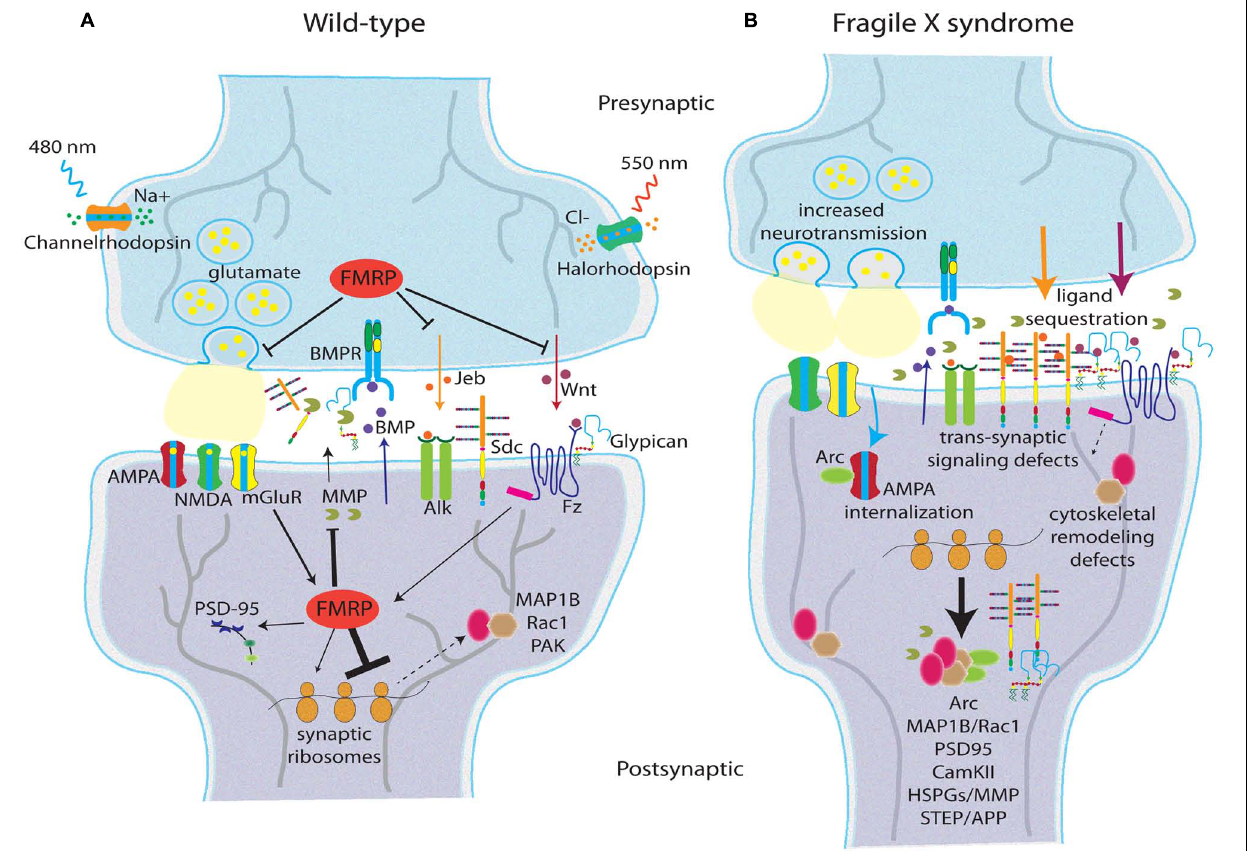
FIGURE 2 | Synaptic changes in the Fragile X syndrome disease state. Schematic depictions of glutamatergic synapses in wild type (A) and FXS (B) conditions showing molecular changes in the response to activity. Data reflect human FXS patient studies, as well as mouse and Drosophila FXS animal models. (A) In wild-type, FMRP regulates glutamate release and anterograde trans -synaptic signaling (e.g., Jeb and Wnt), but does not demonstrably affect retrograde signaling (e.g., BMP; Friedman etal., 2013). FMRP acts as a translational repressor limiting synthesis of cytoskeletal regulators (e.g., MAP1B, Rac1, PAK; Zhang etal., 2001; Bongmba etal., 2011; Dolan etal., 2013), AMPA-R regulators (e.g., Arc; Costa etal., 2012; Niere etal., 2012), MMPs (Bilousova etal., 2009), and heparan sulfate